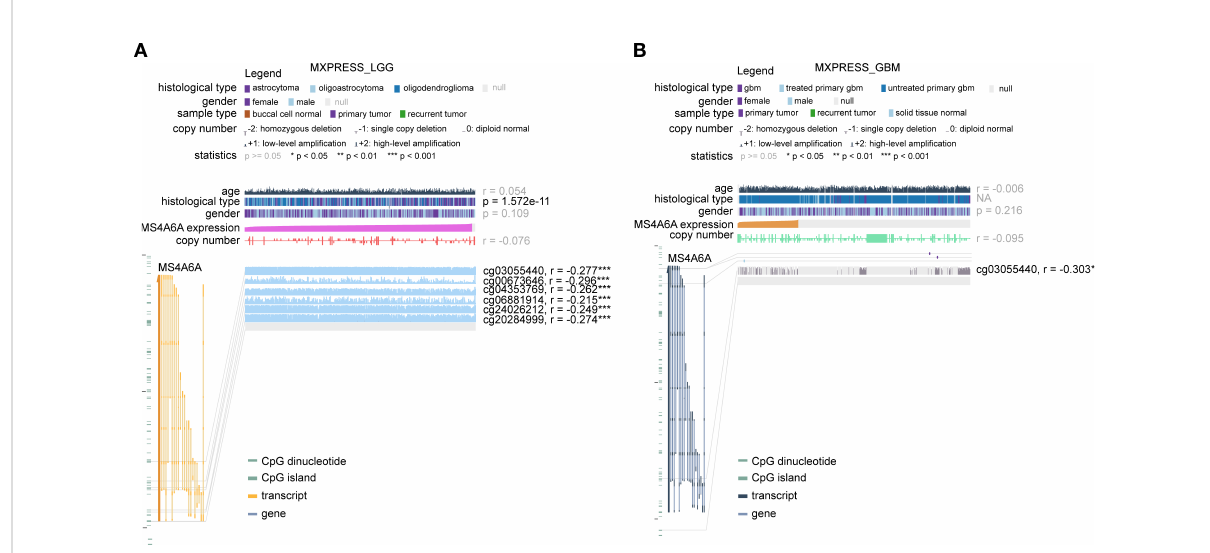
FIGURE 2 The DNA methylation level of MS4A6A in LGG (A) and GBM (B) correlates negatively with the MS4A6A expression level using data from the MEXPRESS database. ***P < 0.001.